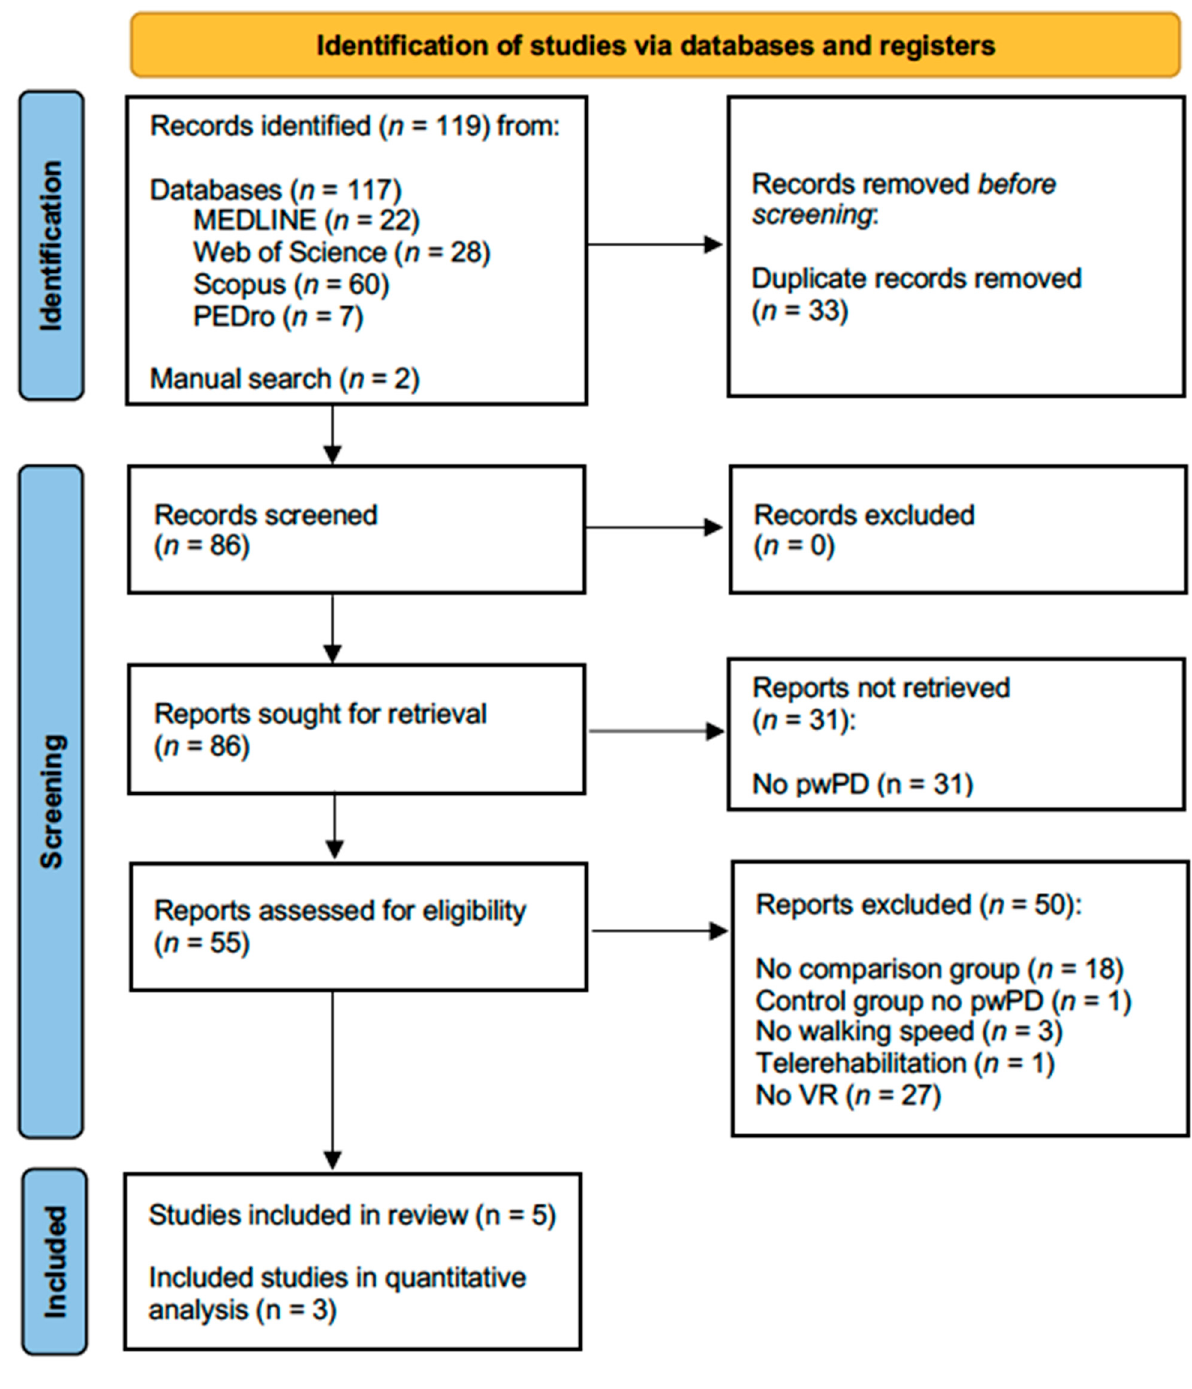
Figure 1. Flowchart of the selection process according to PRISMA standards [30].